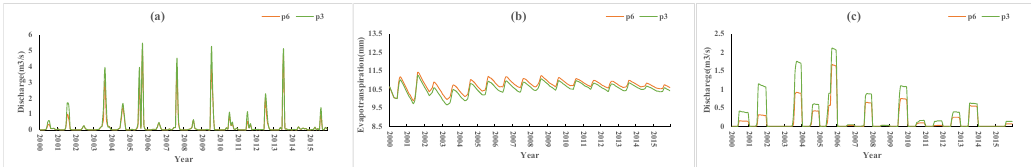
Figure 13. P6 vs. P3 simulation results: ( a ) surface runoff, ( b ) evapotranspiration, ( c ) farmland runoff.